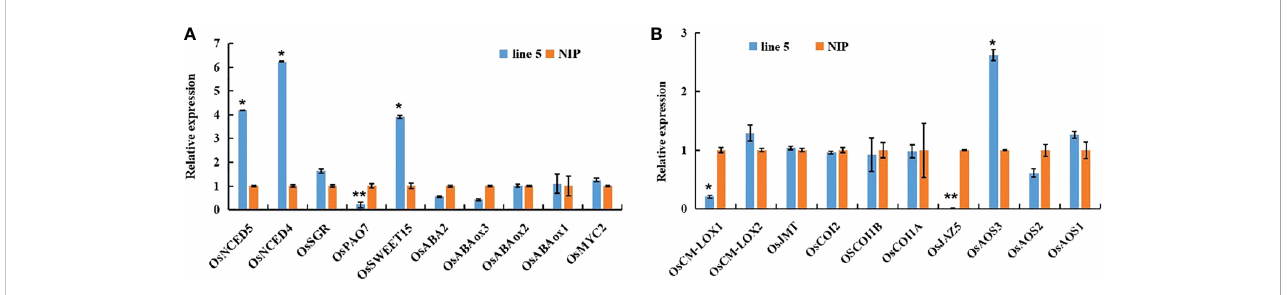
FIGURE 5 Expression of ABA- and JA-related genes at the seedling stage. (A) expression of ABA-related genes including biosynthetic genes OsNCED4 (LOC_Os07g0154201), OsNCED5 (LOC_Os12g0617250), OsPAO7 (LOC_Os09g0368500) and OsABA2 (LOC_Os04g0452500) and inactivation genes OsABAox1 (LOC_Os02g0703600), OsABAox2 (LOC_Os08g0472800) and OsABAox3 (LOC_Os09g0457250), and signaling transduction genes including OsSGR (LOC_Os09g0532000), OsSWEET15 (LOC_Os02g0513100), and positive regulator OsMYC2 (LOC_Os10g0575000). (B) expression of JA-related genes including biosynthetic genes OsAOS1 (LOC_Os03g0767000), OsAOS2 (LOC_Os03g0225900), OsAOS3 (LOC_Os02g0218700) and OsJMT (Os06g0313440) and signaling transduction genes including OsCOI1A (LOC_Os01g0853400), OsCOI1B (LOC_Os05g0449500), OsCOI2 (LOC_Os03g0265500), OsJAZ5 (LOC_ Os07g0153000), OsCM-LOX1 (LOC_Os12g0559934) and OsCM-LOX2 (LOC_Os02g0194700). Error bars indicate means ± SD (n = 3). * r ≤ 0.05, ** r ≤ 0.01 by Student ’ s t test.